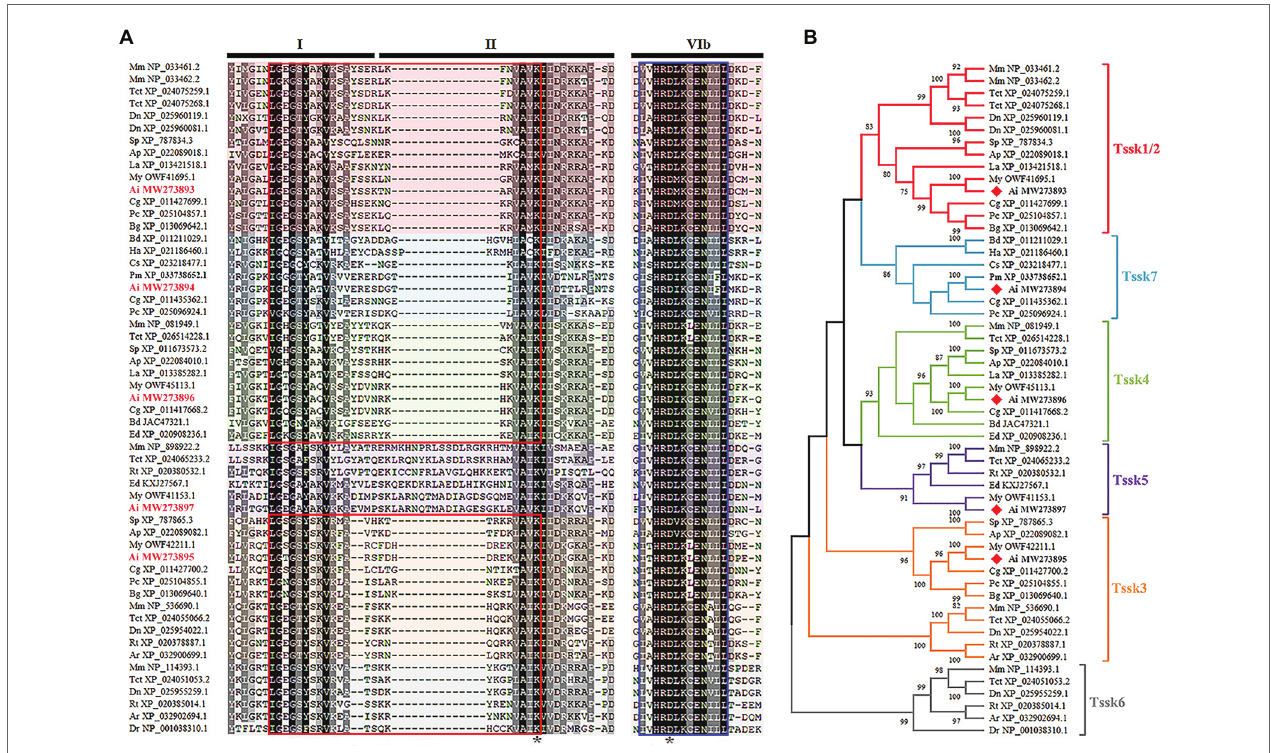
FIGURE 2 | Multiple alignment and phylogenetic analysis of Tssk genes. (A) The multiple sequence alignment of region I, II, and VIb of Tssk proteins from various species. Identical residues were represented in black and similar residues in gray. The ATP-binding region was marked with a red box and the potential serine/ threonine protein kinases active site was marked with a blue box. The asterisks denoted the indispensable residues of lysine and aspartic acids in the S_TKc domain. (B) Phylogenetic analysis of the Tssk family genes based on the S_TKc domain. The phylogenetic tree was built using the NJ method in MEGA X software. Tssk proteins of the bay scallop were labeled with red diamonds. The species abbreviations are as follows: Mus musculus (Mm), Dromaius novaehollandiae (Dn), Terrapene carolina triunguis (Tct), Rhincodon typus (Rt), Amblyraja radiata (Ar), Danio rerio (Dr), Strongylocentrotus purpuratus (Sp), Acanthaster planci (Ap), Helicoverpa armigera (Ha), Bactrocera dorsalis (Bd), Centruroides sculpturatus (Cs), Lingula anatina (La), Crassostrea gigas (Cg), Argopecten irradians (Ai), Mizuhopecten yessoensis (My), Pecten maximus (Pm), Biomphalaria glabrata (Bg), Pomacea canaliculata (Pc), and Exaiptasia diaphana